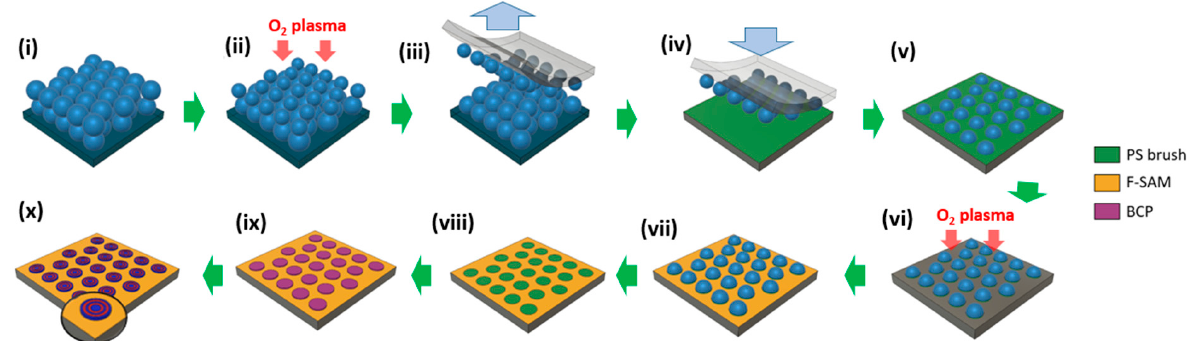
Figure 1. Schematic of the overall experimental process: ( i ) Multilayered colloidal crystal structure; ( ii ) O 2 plasma etching of the surface layer of the colloidal crystal; ( iii ) peeling of the surface layer of the colloidal crystal using a PDMS stamp; ( iv ) transfer of the colloidal crystal monolayer to the PS brush substrate; ( v ) resulting non-close-packed hemispherical colloidal crystal monolayer on the PS brush substrate; ( vi ) O 2 plasma etching to remove the exposed areas of the PS brush layer; ( vii ) F- SAM deposition on the exposed surfaces; ( viii ) F-SAM-patterned guiding template upon the re- moval of the colloidal particles; ( ix ) area-selective dewetting of the BCP thin film; ( x ) microphase separation of the BCP film via solvent vapor annealing.